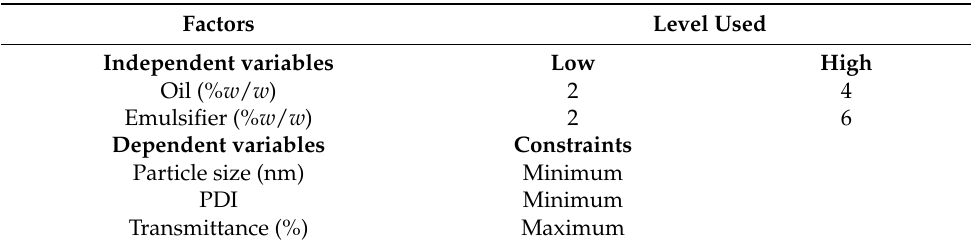
Table 1. Selected independent variables for the optimization of lidocaine-loaded nanoemulsion using CCD.